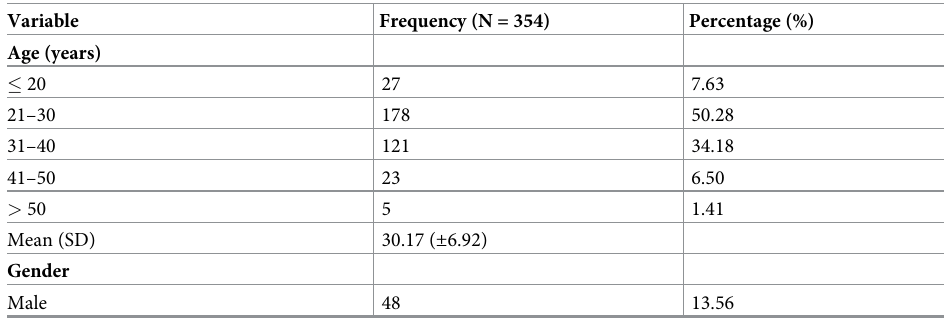
Table 2. Socio-demographic profile of